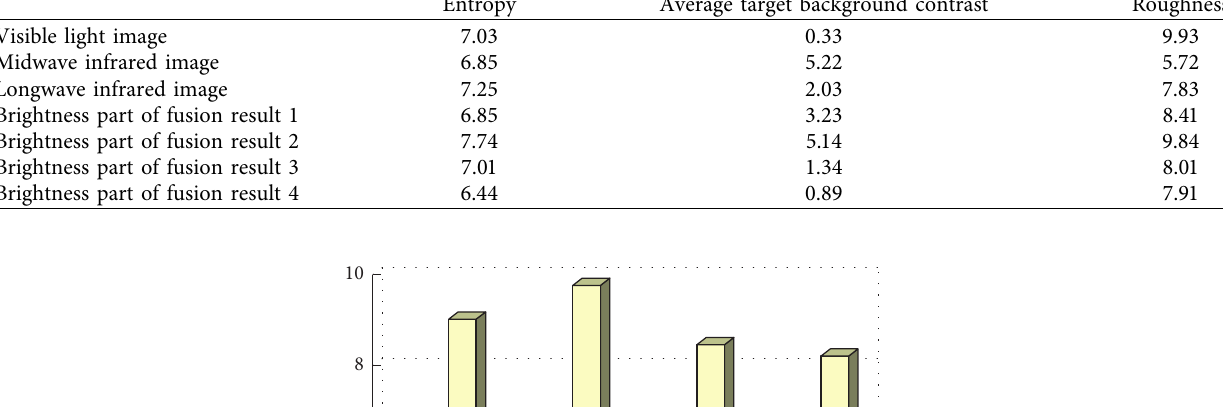
Figure 8: The regression model of urban context against SE. Table 1: Comparison of gray information between source image and YIQ transformed color hand-drawn image. Entropy